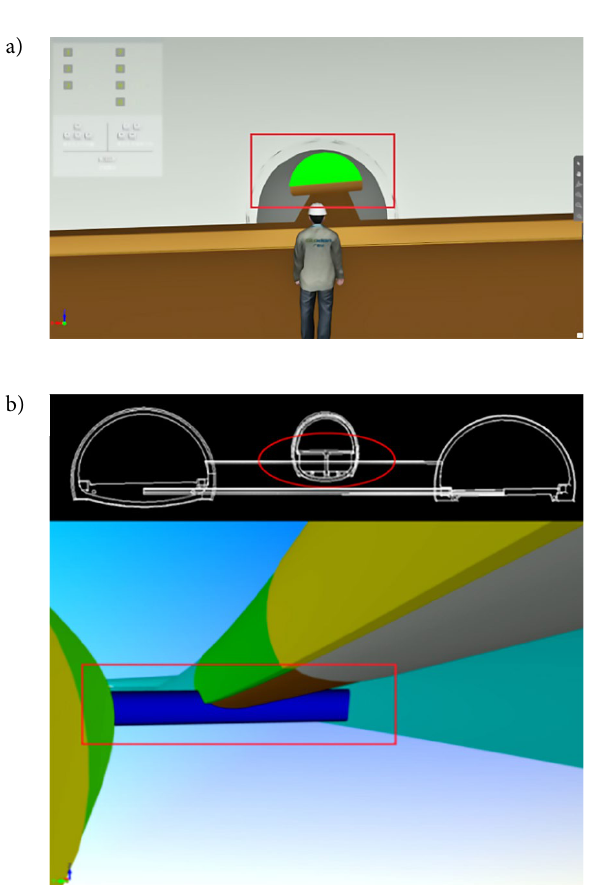
Figure 7. Use BIM 3D model to realize roaming collision detection: a – a structural error is detected; b – the BIM 3D model and 2D drawing are compared to find design errors and